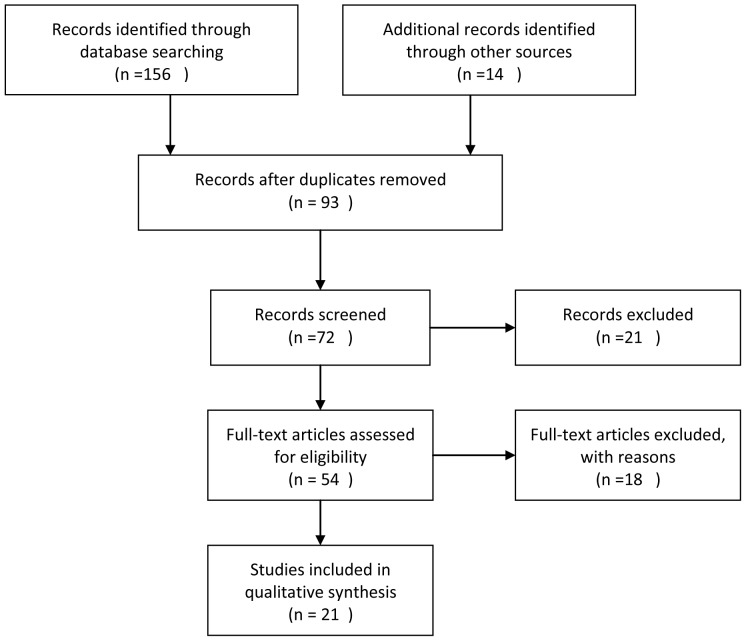
Flowchart of systematic search.